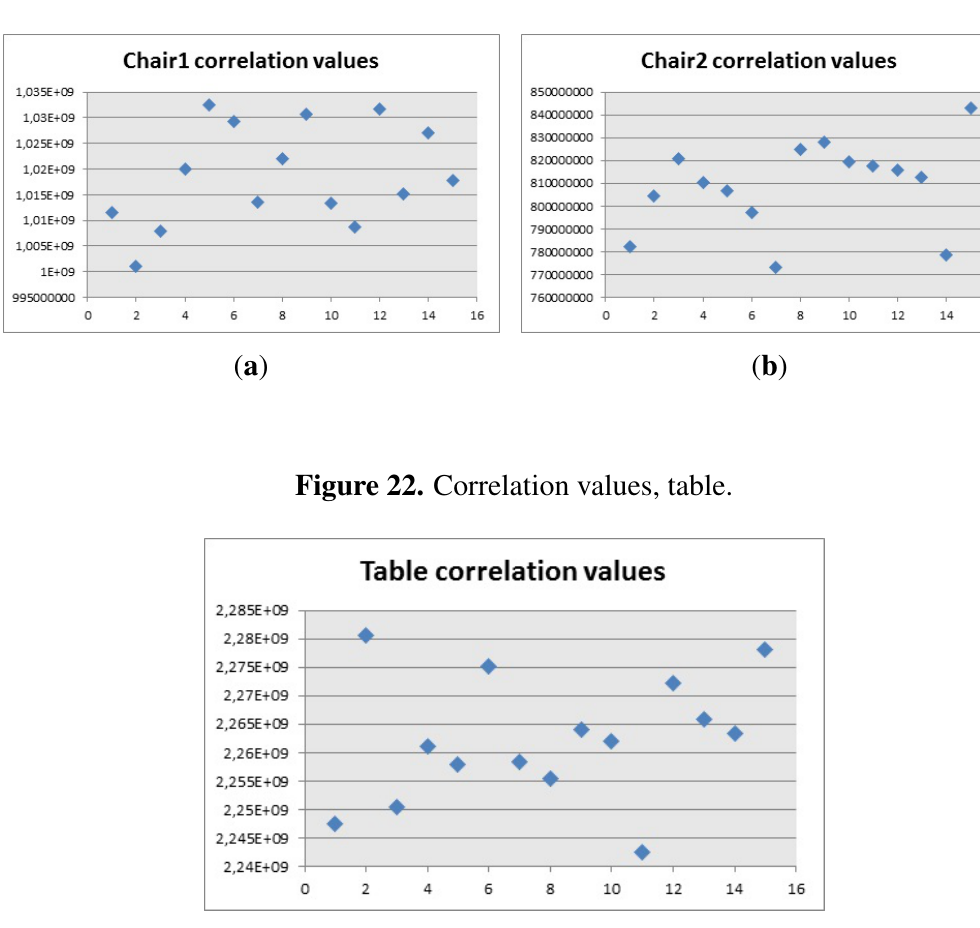
Figure 21. Correlation values, experiment 2. ( a ) Correlation values, chair 1; ( b ) Correlation values, chair 2.